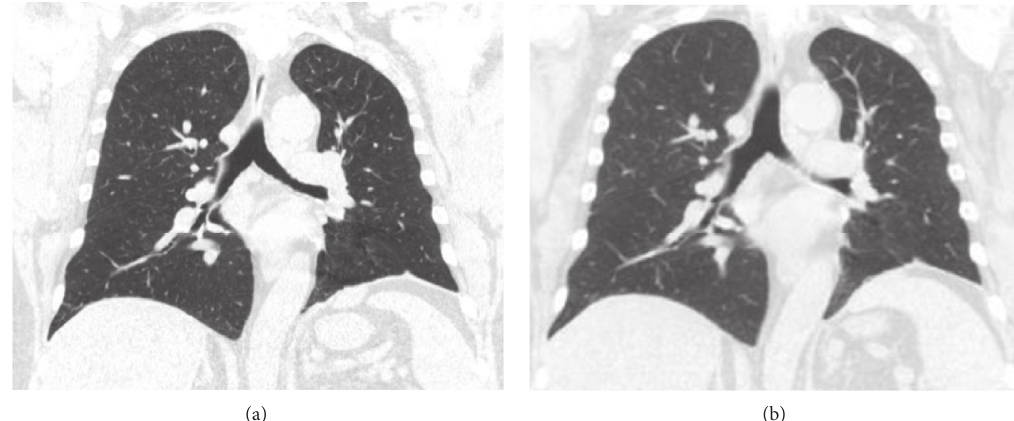
Figure 3: Comparison of coronal images from noncontrast, high-resolution chest computed tomography (CT) before and after COVID-19 pneumonia. (a) demonstrates a coronal slice of the patient’s high-resolution chest CT1.5 years prior to presentation. (b) is a follow-up